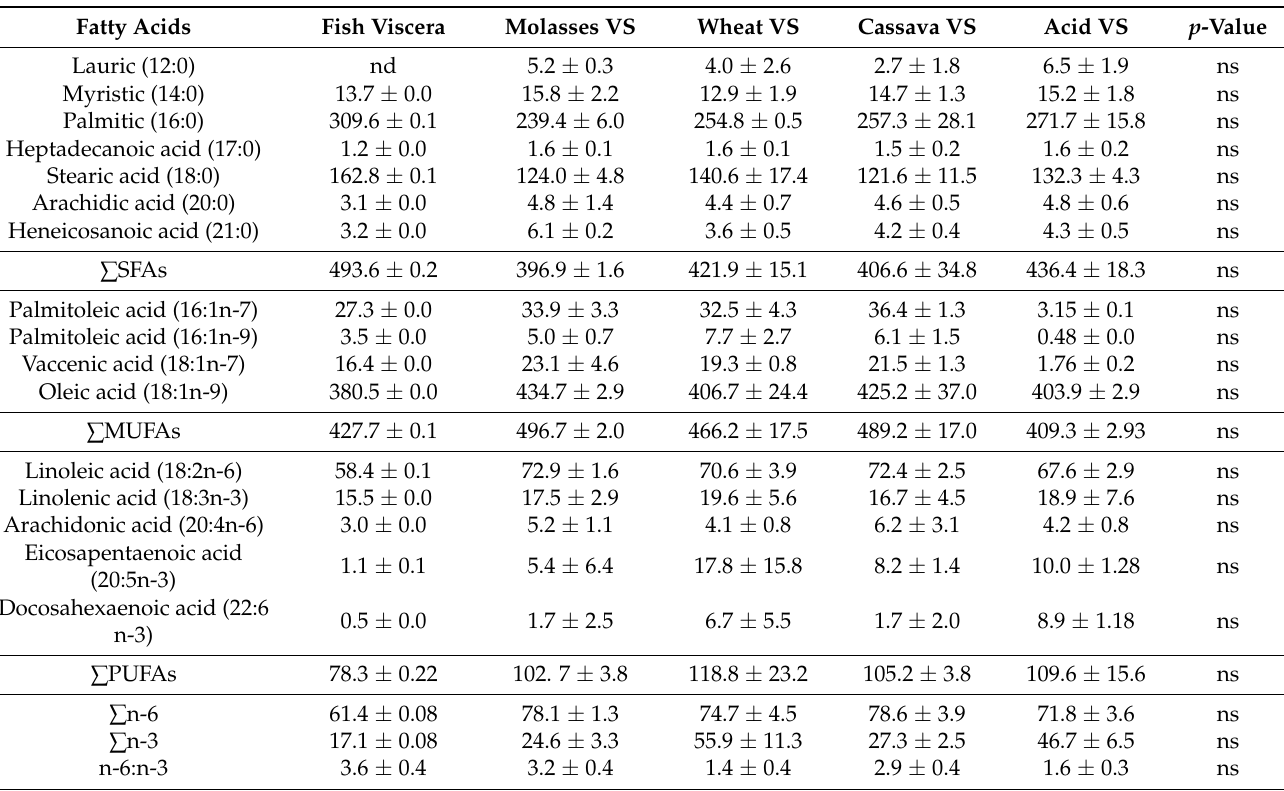
Table 4. Fatty acids of fish viscera and viscera silages after 7 days of storage (mg · g − 1